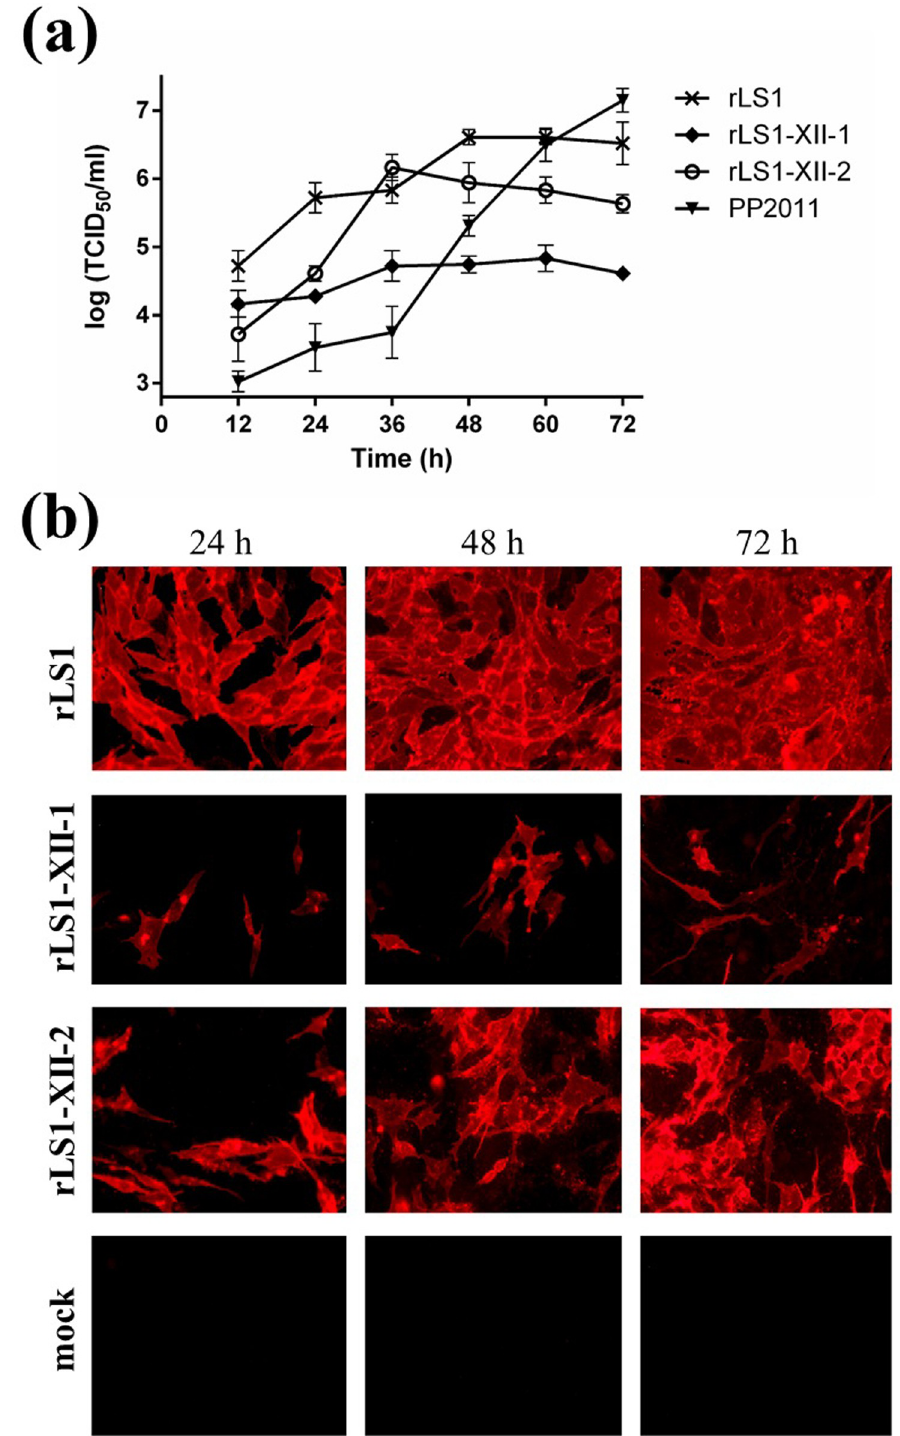
Fig 2. Characterization of recombinant viruses. (a) Multistep growth curves of rLS1, rLS1-XII-1 and rLS1-XII-2 in DF-1 cells. Cells were infected at a MOI of 0.05 and supernatants were collected in 12 hours intervals post-infection and titered by TCID 50 /ml. Data was taken from three independent experiments. (b) In vitro infection patterns of the rNDVs. DF-1 cells were infected with a MOI of 0.01 for 1 hour and then covered with DMEM semisolid media containing 0.75% methylcellulose. After 24, 48 and 72 h, cell monolayers were washed and stained for NDV by immunofluorescence. All pictures were taken at 400X magnification. https://doi.org/10.1371/journal.pone.0209539.g002 PLOS ONE | https://doi.org/10.1371/journal.pone.0209539 November14,